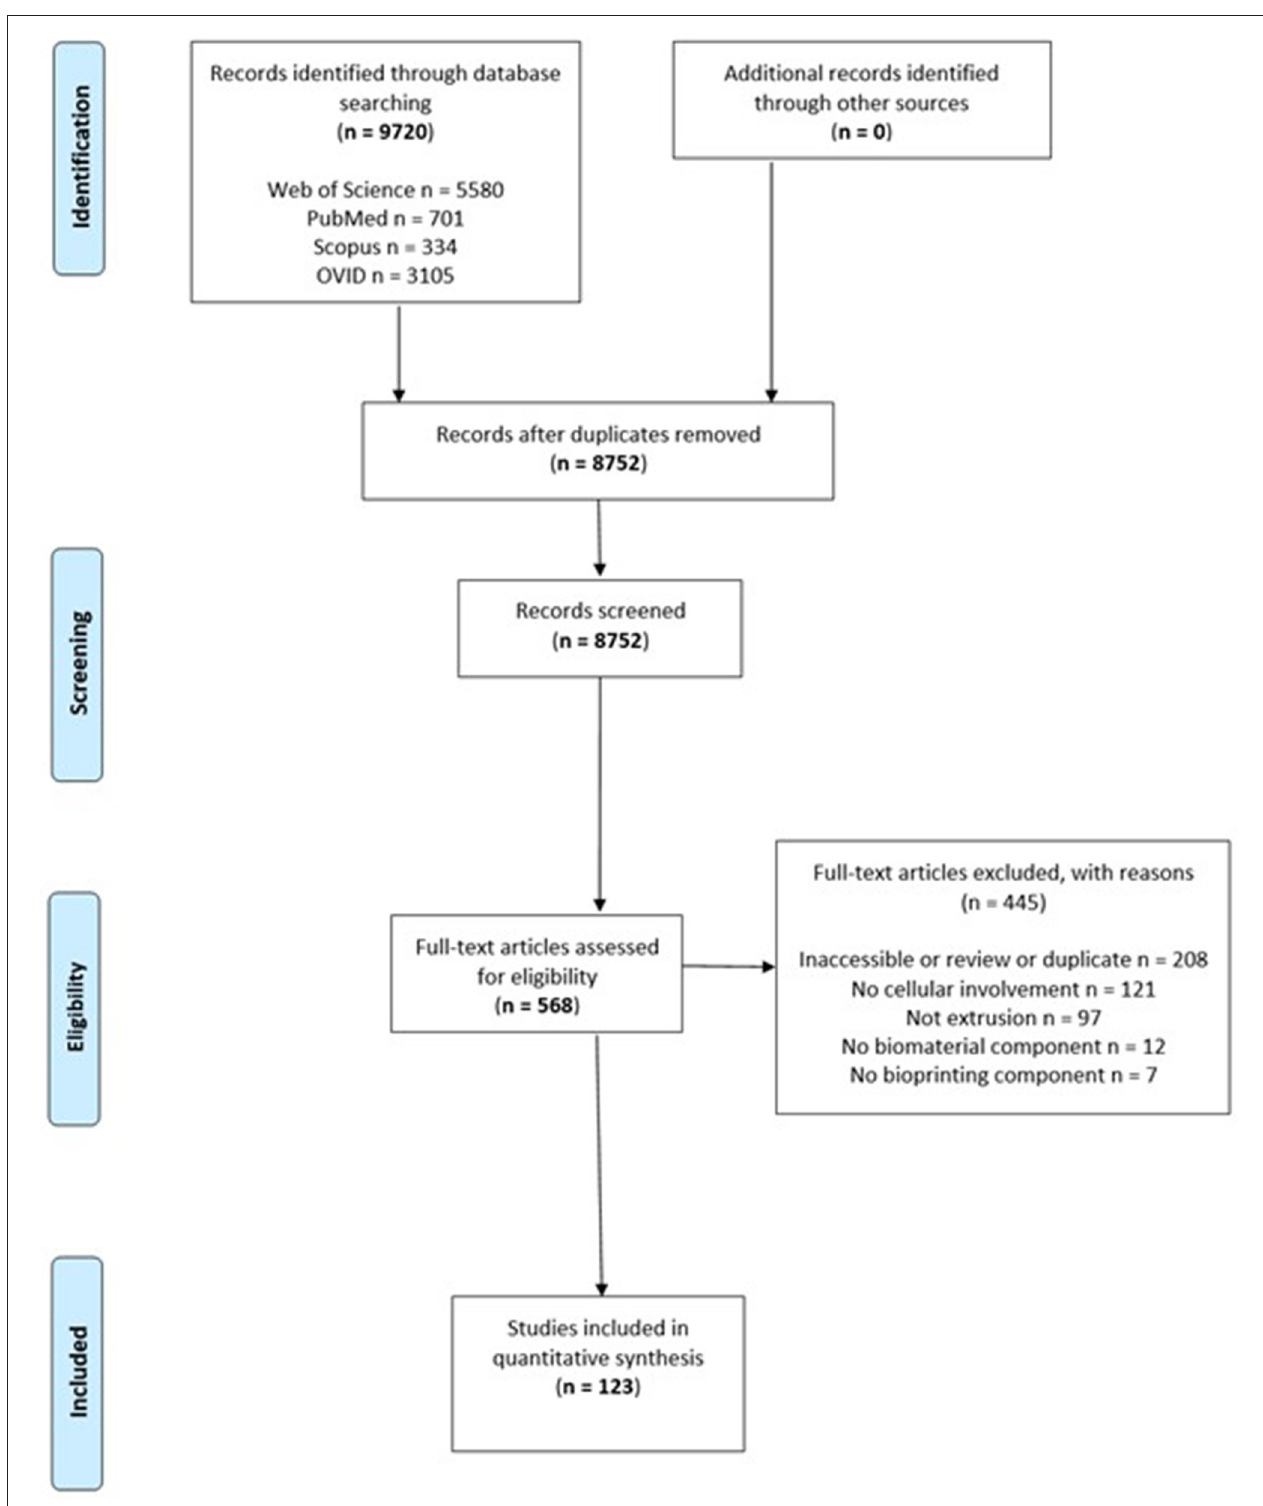
FIGURE 2 | Preferred Reporting Items for Systematic Reviews and Meta-Analyses flow chart of included studies.